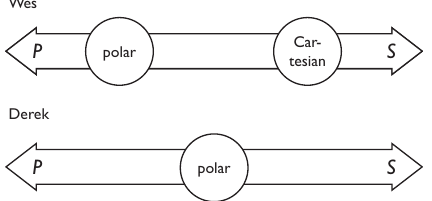
FIG. 6. Two plasticity charts for the week 4 miniview. Wes’s graph is on top, Derek’s below. Wes’s polar resource is more plastic than both his Cartesian one and Derek’s polar , but we do not have enough evidence to learn how solid Derek’s polar is.